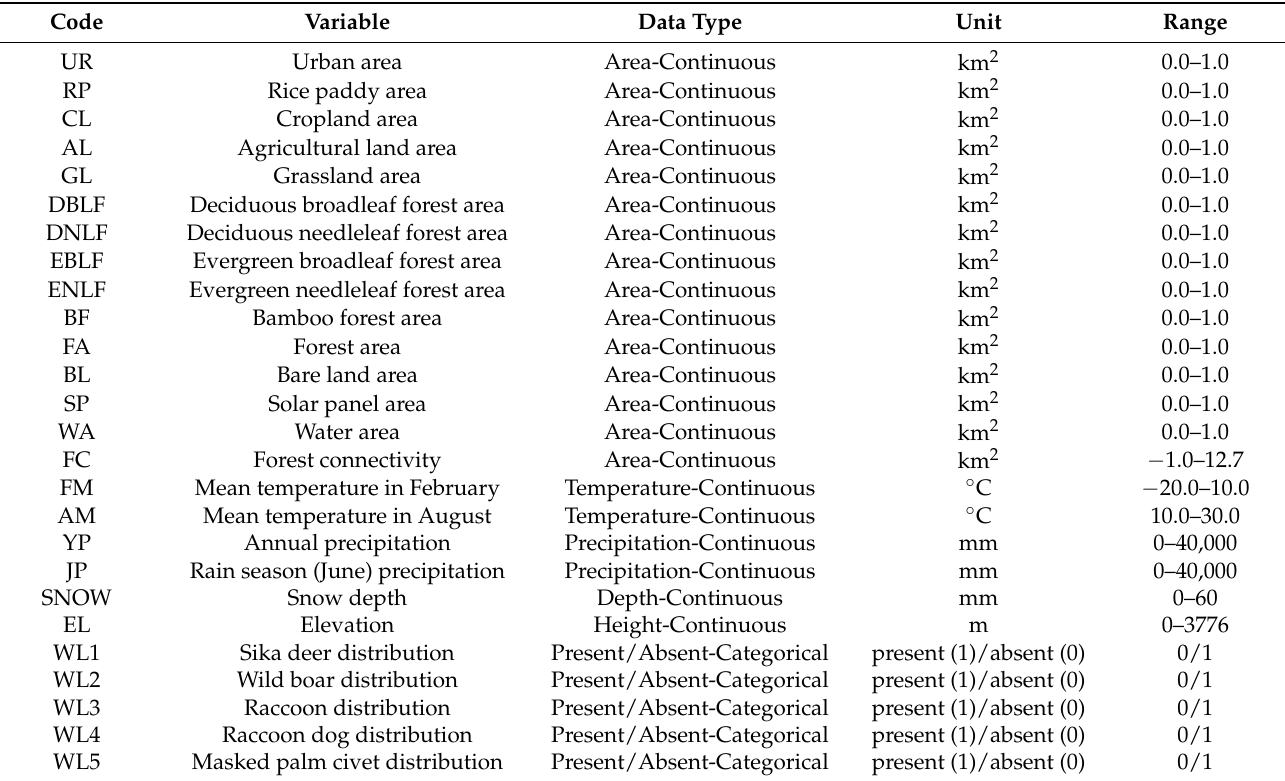
Table 1. Land-use, climatic, and wildlife variables used as background factors for the prediction of tick distributions. All variables were obtained as raster data with a resolution of 1 km 2 geographical